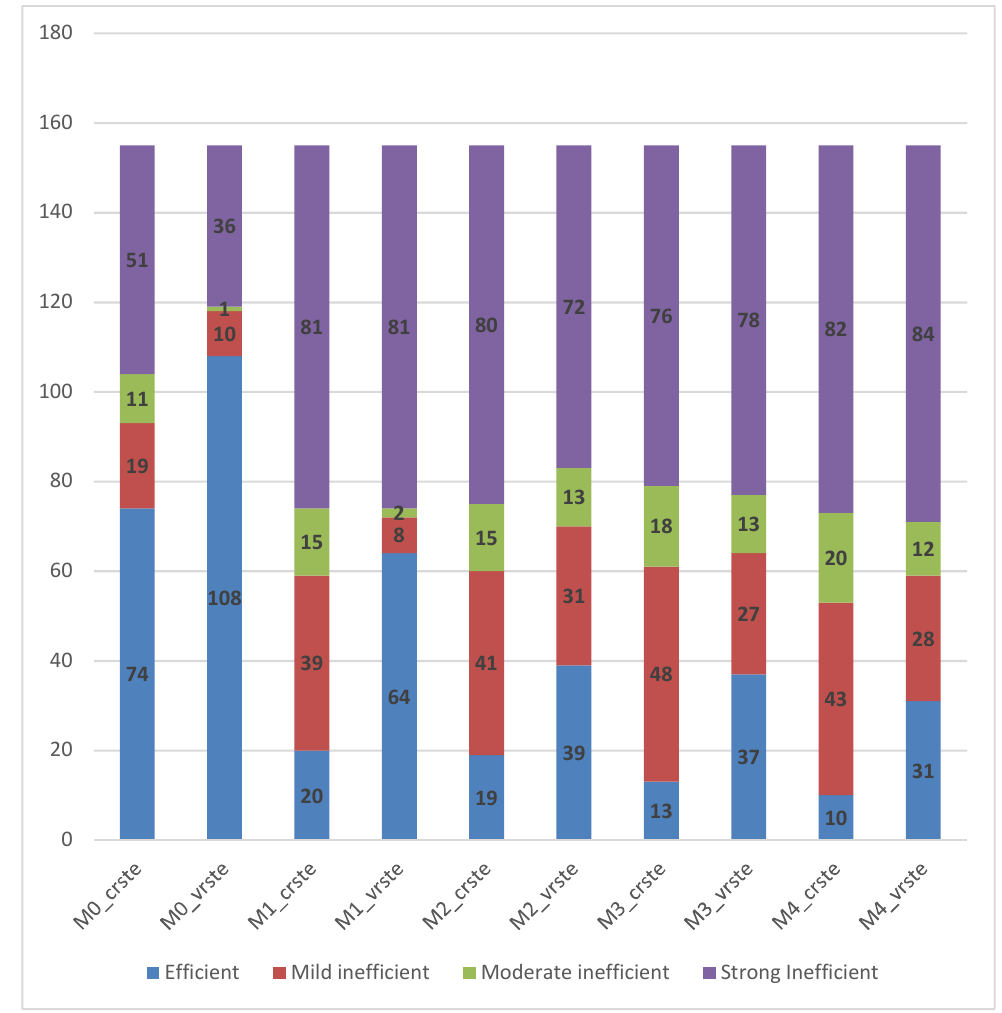
Figure 1. Efficient, mild inefficient, moderate inefficient, and strong inefficient health centers.